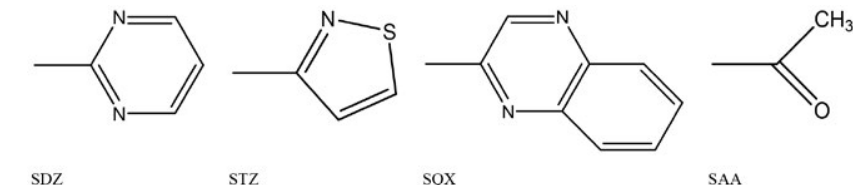
Scheme 2. Sketch map of R group structure for all studied